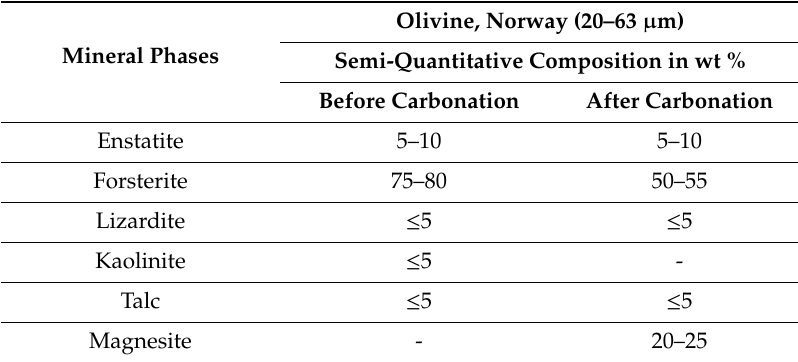
Table 2. The semi-quantitative XRD analysis before and after carbonation.